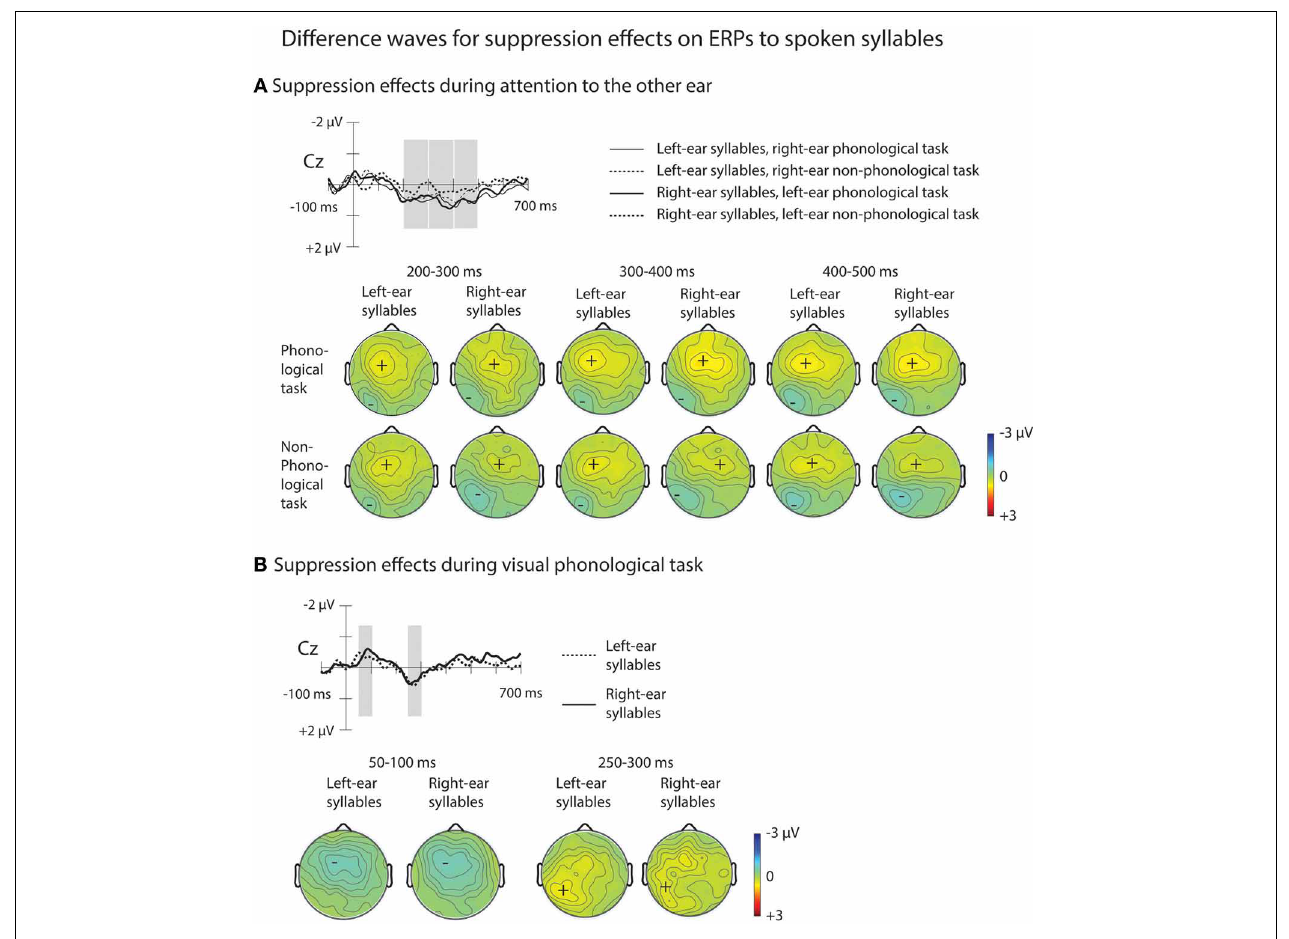
FIGURE 5 | ERP difference waves illustrating suppression effects on ERPs to spoken syllables (please note that for illustrative purposes, the amplitude scales differ from those used for ERPs in Figures 3, 4). (A) Difference waves for suppression effects on ERPs to left-ear syllables during the right-ear phonological task at Cz electrode were obtained by subtracting grand-average ERPs to left-ear standard syllables during the visual non-phonological task from grand-average ERPs to the left-ear standard syllables during the right-ear phonological task (thin solid line; for the grand-average ERPs, see Figure 3B ). Difference waves for suppression effects on ERPs to the right-ear syllables during the left-ear phonological tasks were obtained by subtracting grand-average ERPs to the right-ear syllables during the visual non-phonological task from grand-average ERPs to the right-ear syllables during the left-ear phonological task (thick solid line). Difference waveforms for non-phonological tasks were obtained accordingly (thin dotted line for left-ear syllables and thick dotted line for right-ear syllables during non-phonological tasks to the other ear, respectively). Maps